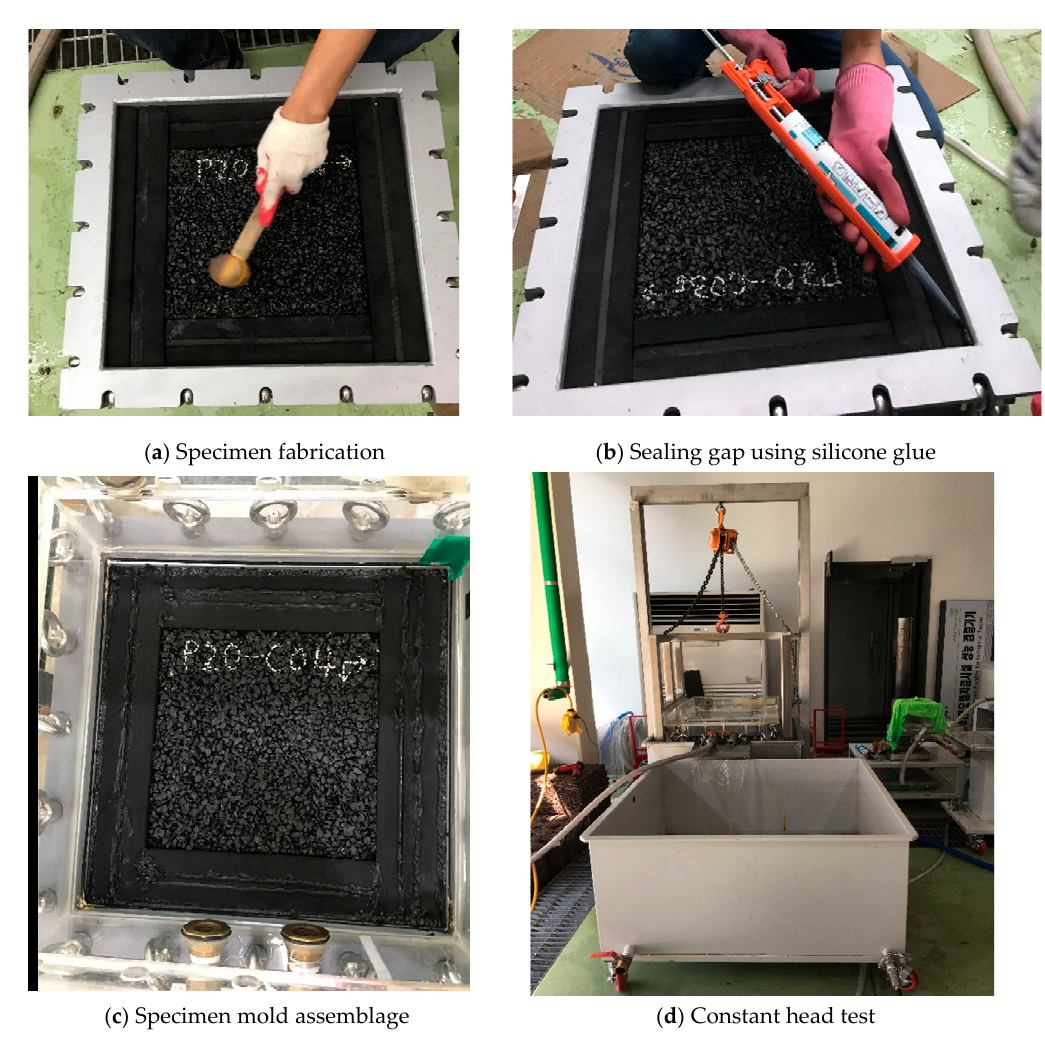
Figure 4. Vertical permeability test for porous asphalt specimen (after Ahn et al. [24] ). Table 2. SWCC parameters for the PFC pavement (after Lim and Kim